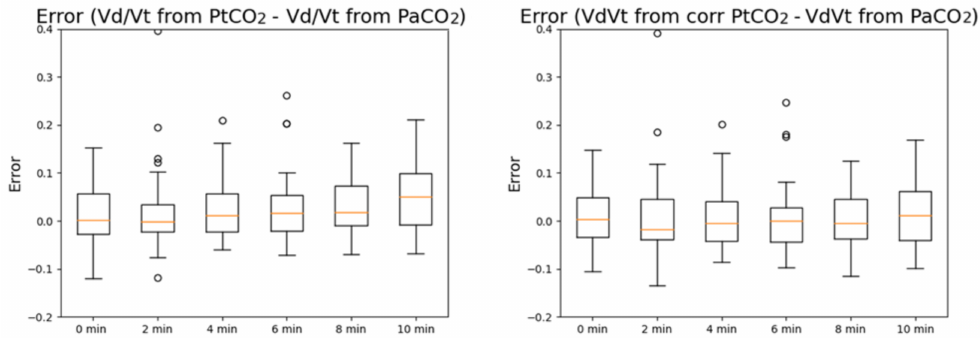
Figure 5. Boxplots of the measurement errors of V D /V T computed with PtCO 2 ( left ) and V D /V T computed with the corrected PtCO 2 ( right ) at different timestamps with respect to V D /V T computed with PaCO 2 . The errors are expressed in mmHg.